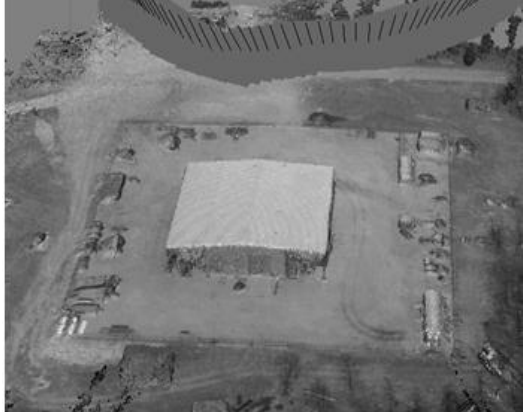
Figure 8. Dense point cloud created by Agisoft PhotoScan from single circular flight over machine storage area using the NGA quadcopter with a GoPro flat lens